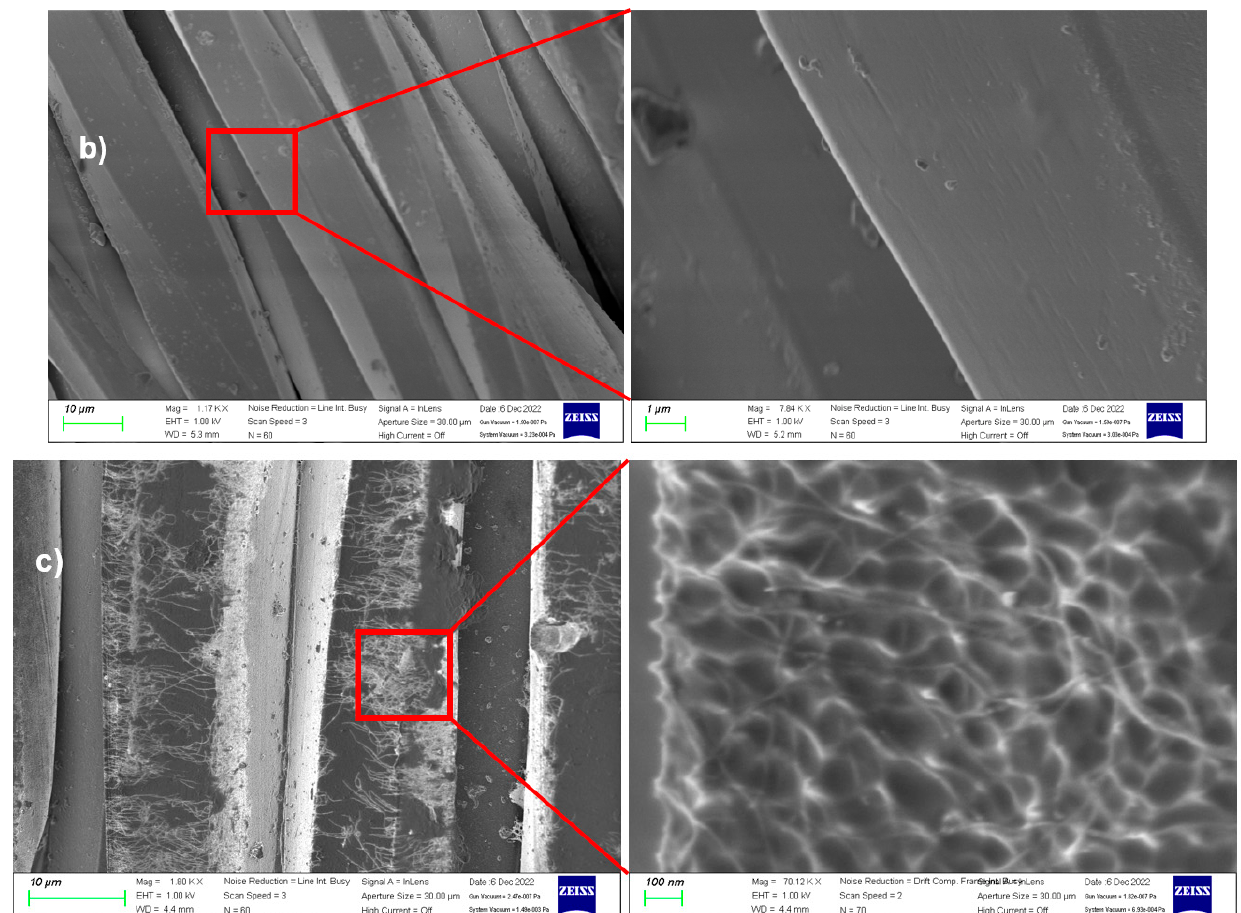
Figure 4. The SEM images of ( a ) SWCNT, ( b ) non-conductive fabric, and ( c ) conductive yarn.